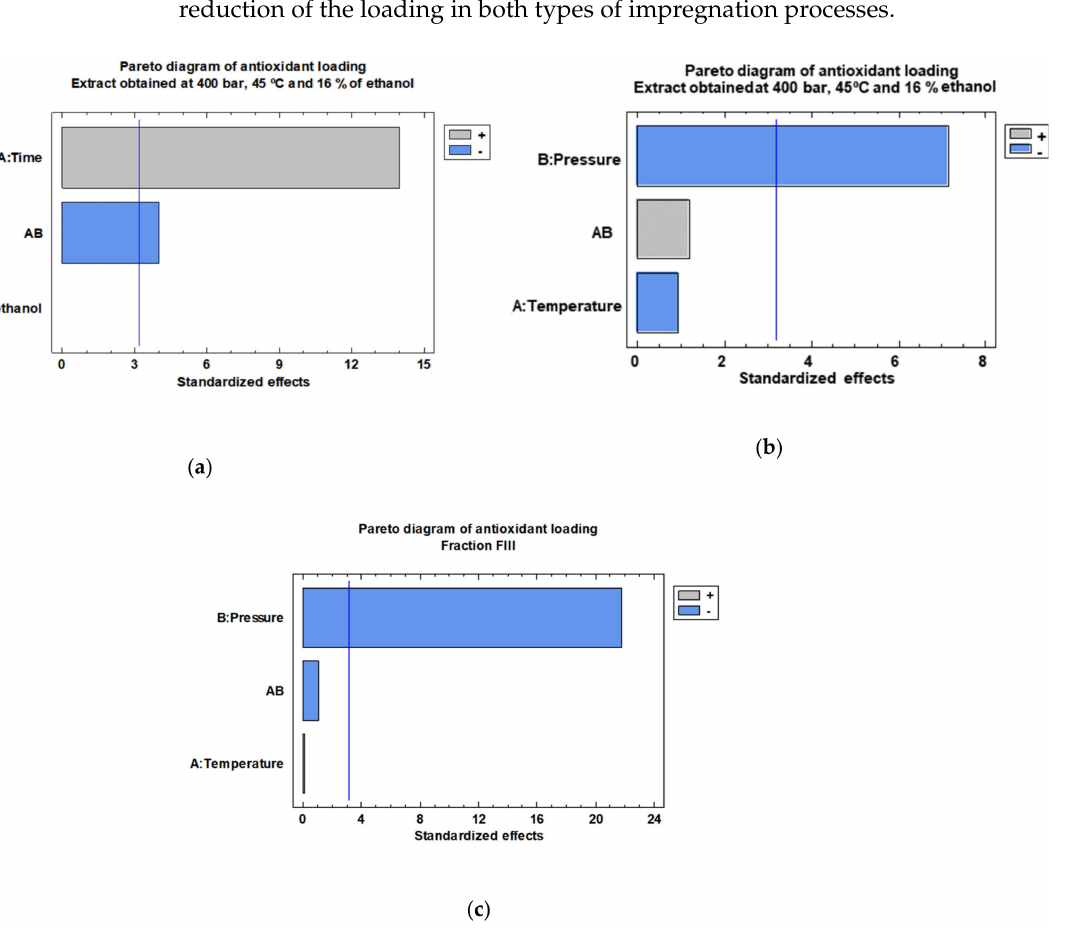
Figure 6. Pareto diagrams of the 400 bar 45 ◦ C extract loading obtained under different impregnation conditions: ( a ) percentage of cosolvent and impregnation time, ( b ) pressure and temperature. Pareto diagram of the FIII fraction loading ( c ) ( p =